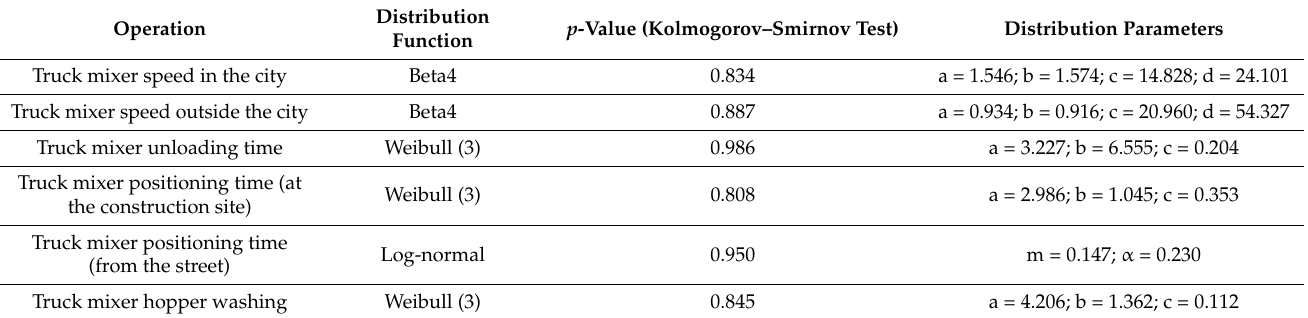
Table 5. Probability distributions for the simulation